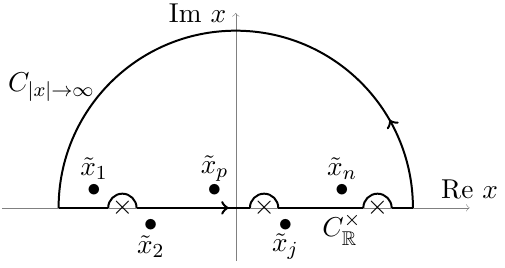
+ C and ˜ x + i(cid:15) ( t − t ) i ≡ x i i R | x |→∞ part of the contour is a real integration in the Cauchy R